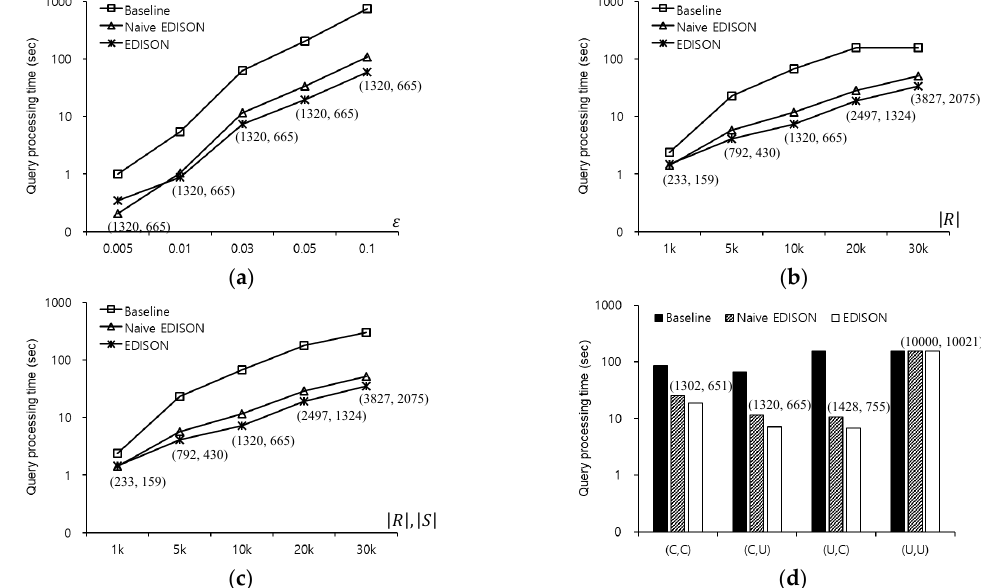
Figure 16. Comparison of the baseline, naive EDISON, and EDISON methods for FLA ( a ) varying ε ; ( b ) varying | R | ; ( c ) varying | R | and | S | ; ( d ) varying the distributions of objects.